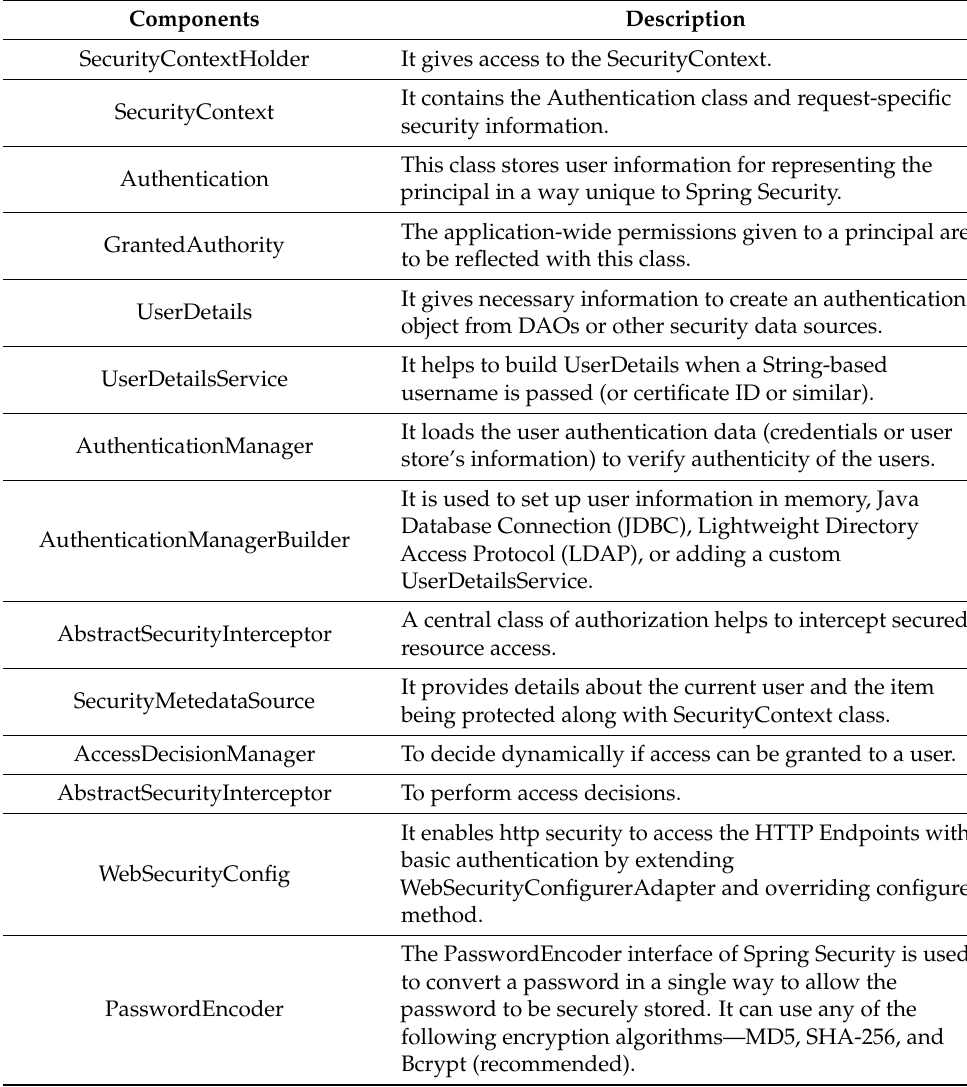
Table 1. Selected list of core security components of Spring Security